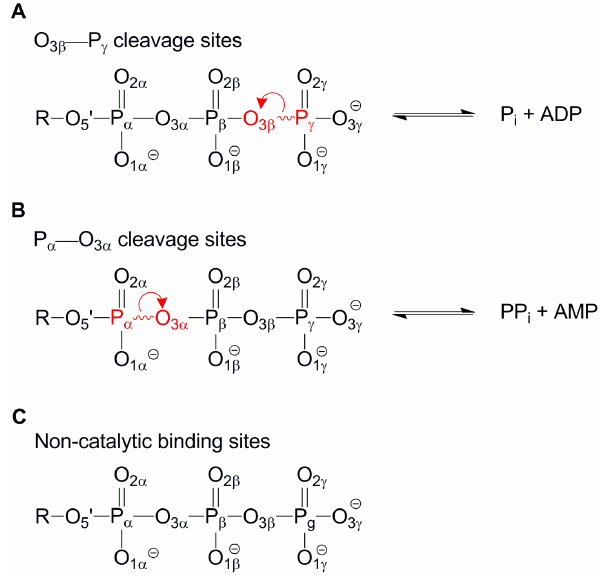
Figure 1. Enzyme structures can be categorized according to the fate of the bound nucleoside triphosphate (NTP). A) Phosphoryl transfer in which the O 3 b _P c bond is cleaved. B) Reactions in which the P a _O 3 a bond is cleaved and C) Structures where the bound NTP does not undergo a chemical reaction. Red lettering indicates the atoms in the scissile bond and red arrows depict the transfer of electrons in going from reactants to products.